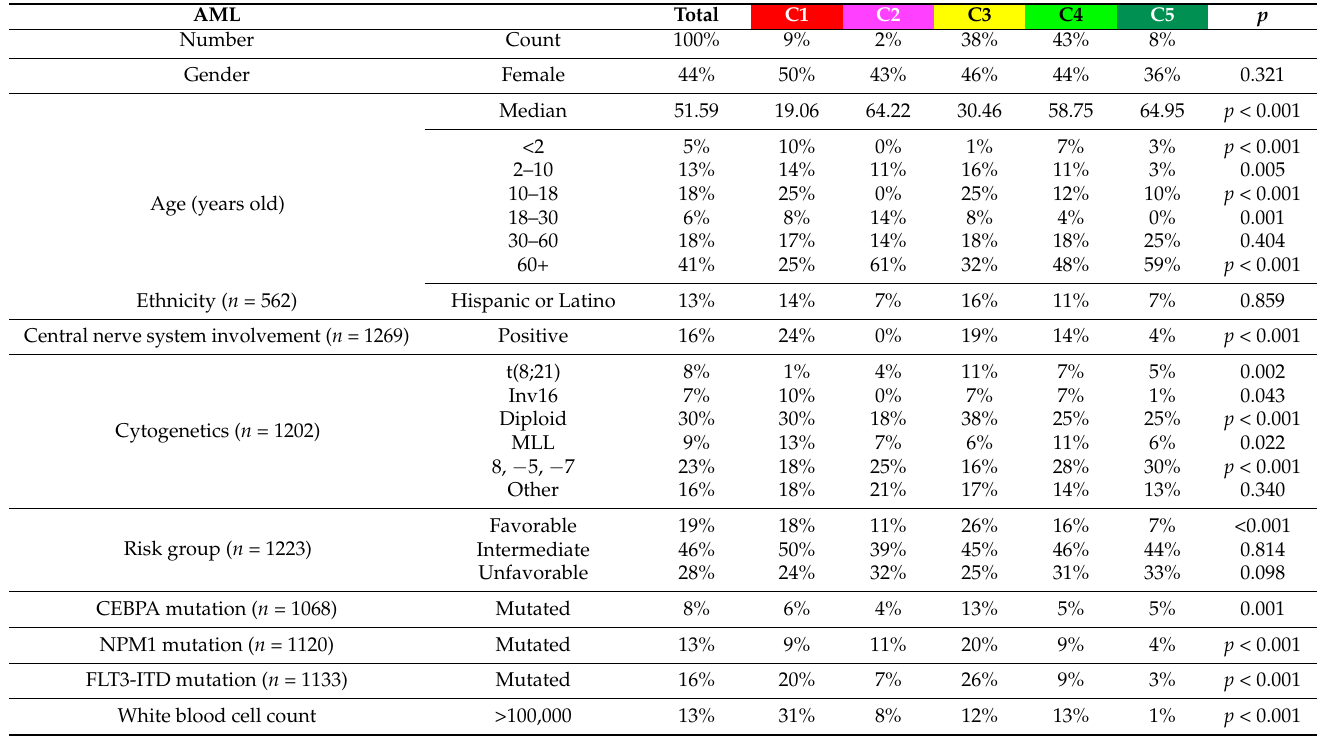
Table 2. Patient and disease characteristics across the five protein clusters in acute myeloid leukemia.